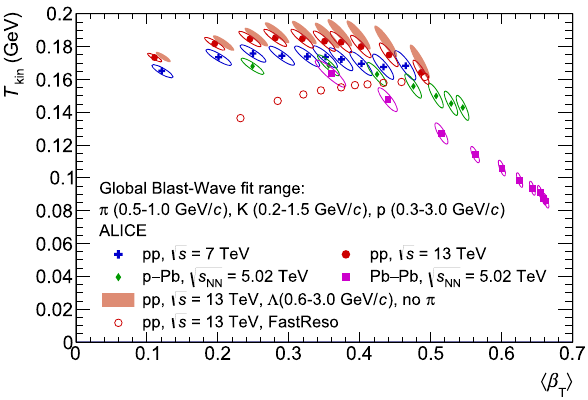
Fig. 3 Correlation of kinetic freeze-out temperature T kin and average expansion velocity (cid:4) β T (cid:5) , extracted from simultaneous Blast-Wave fits to π , K, and p spectra measured in pp, p–Pb, and Pb–Pb collisions. Contours represent 1 σ uncertainty. The shaded ellipses represent the (cid:4) β (cid:5) - T (cid:11) √ T kin correlation calculated from Blast-Wave fit to K, p, and s = 13 TeV. The empty spectra [23] measured in pp collisions at circlesrepresentBlast-Wavefitswithresonancedecays[44].References from [10–12,44]